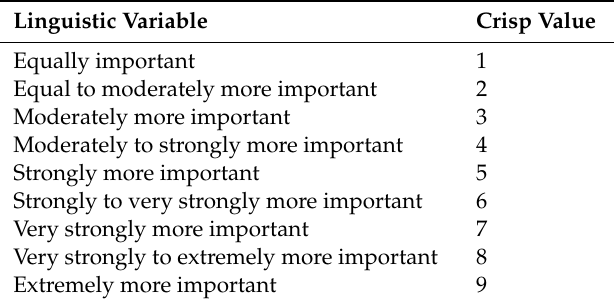
Table 2. BWM evaluation